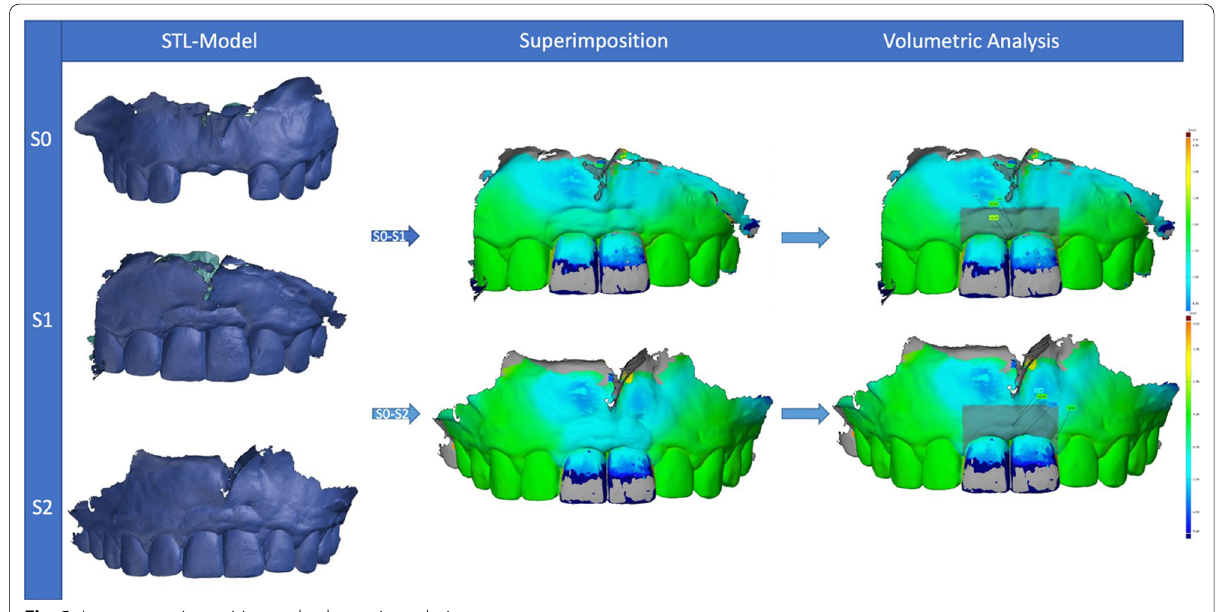
Fig. 2 Image superimposition and volumetric